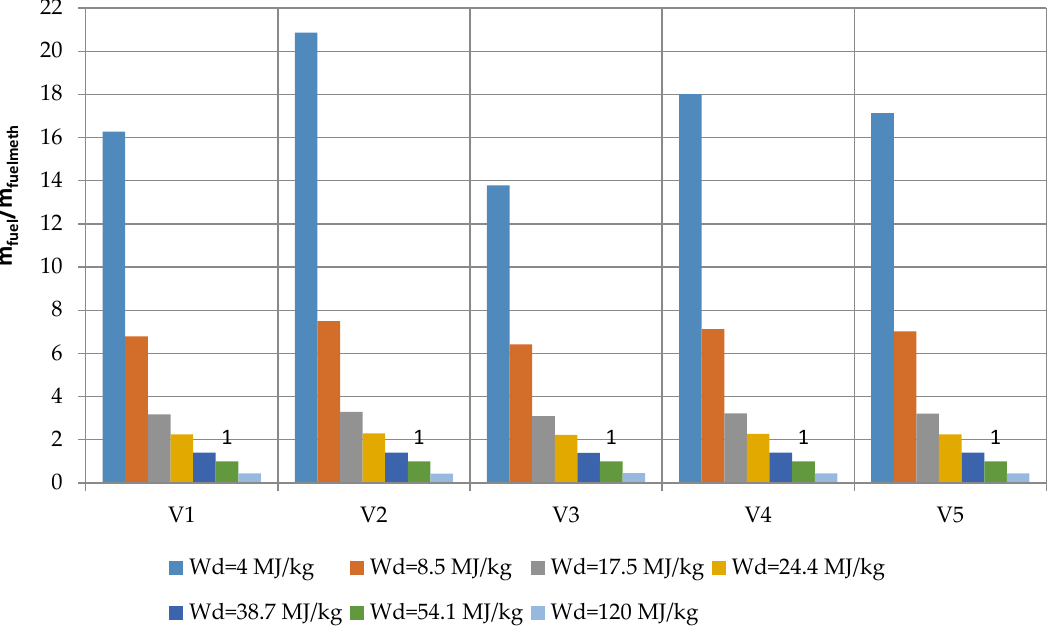
Figure 13. Collective diagram of the effect of the structure of cycle and calorific value of fuel on the mass flux of the fuel recorded in the combustion chamber in relation to the variants of circulation with methane fuel.